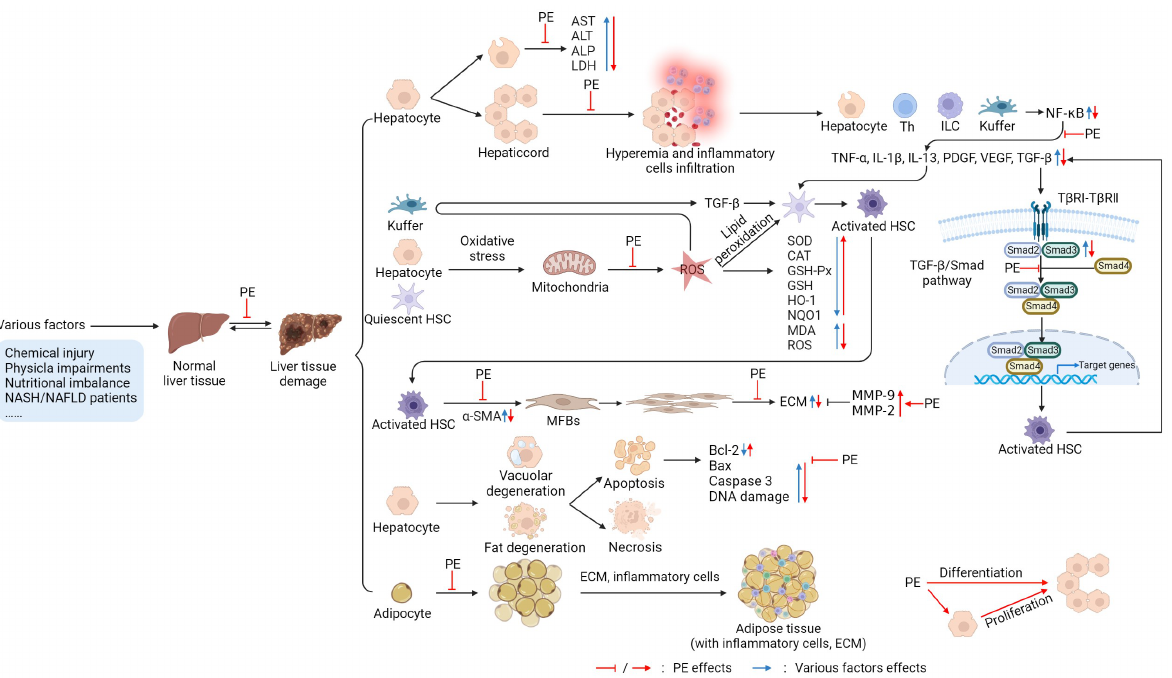
Figure 2. Targets of PE in protecting or treating liver (figure was created using BioRender). After liver injury, the cell membrane permeability is enhanced, or the membrane is depleted of hepatocytes; the release of liver enzymes (aspartate aminotransferase (AST), alanine aminotransferase (ALT), leucine aminopeptidase (ALP), lactic dehydrogenase (LDH)) is increased [50,51,68], and the hepatic sinus is dilated and congested due to inflammatory cell infiltration [62,63]. Damaged hepatocytes and immune cells (T helper (Th) cells, innate lymphoid cells (ILC), Kupffer cells) release inflammatory factors (tumor necrosis factor-alpha (TNF- α ), interleukin (IL)-1 β , IL-13, platelet-derived growth factor (PDGF), vascular endothelial growth factor (VEGF), transforming growth factor- β (TGF- β )) by activating the nuclear factor κ B (NF- κ B) signaling pathway, further activating hepatic stellate cells (HSCs) [58,59,112]. Injury factors can also cause oxidative stress (OS) in Kupffer cells, hepatocytes, and quiescent HSCs; increase mitochondrial reactive oxygen species (ROS) production; decrease liver antioxidant (superoxide dismutase (SOD), catalase (CAT), glutathione peroxidase (GSH-Px), glutathione (GSH)) levels; and improve malondialdehyde (MDA) levels. Moreover, ROS induces Kupffer to produce TGF- β and the lipid peroxidation of HSCs, further activating HSCs [51,77,112]. TGF- β plays a vital role in the process of activating HSCs. First, it interacts with cell membrane receptors to recruit small mothers against decapentaplegic (Smad) 2/3, forms a complex with Smad 4, and then initiates the transcription progress of the target genes by nuclear translocation and activates HSCs. Activated HSCs can release TGF- β to promote the activation of other HSCs [112,113]. In addition, activated HSCs can secrete a large amount of alpha-smooth muscle actin ( α -SMA) and differentiate into myofibroblasts (MFBs). The MFBs proliferate copiously and secrete a large